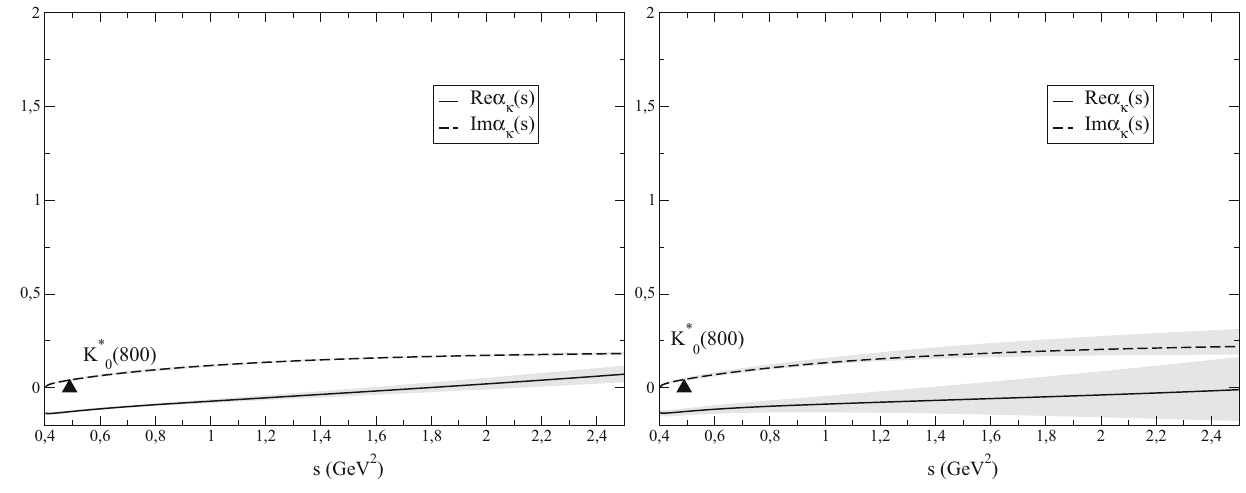
( 800 ) slope of the Regge trajectory is almost one order of magnitude smaller 0 than the usual ones. In addition there cannot be any candidate for this resonance since the real part is below 0.25 up to s = 5 GeV − 2